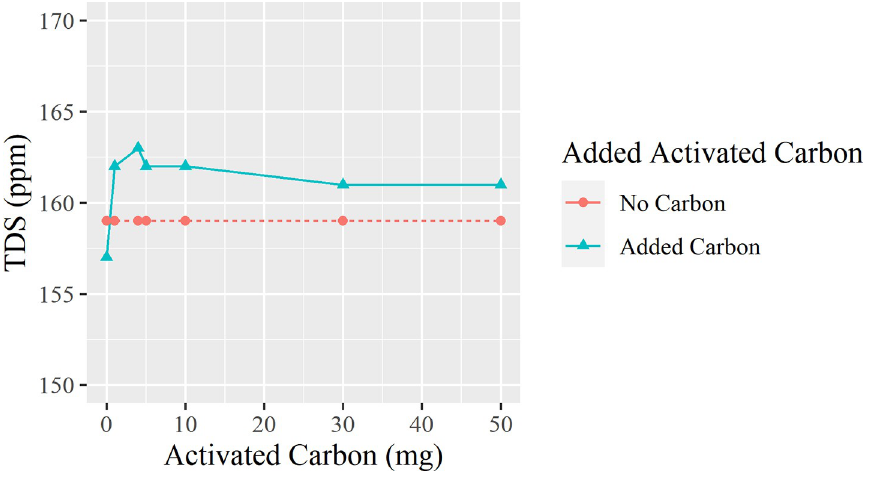
Fig 7. Trend for the effect of activated carbon on